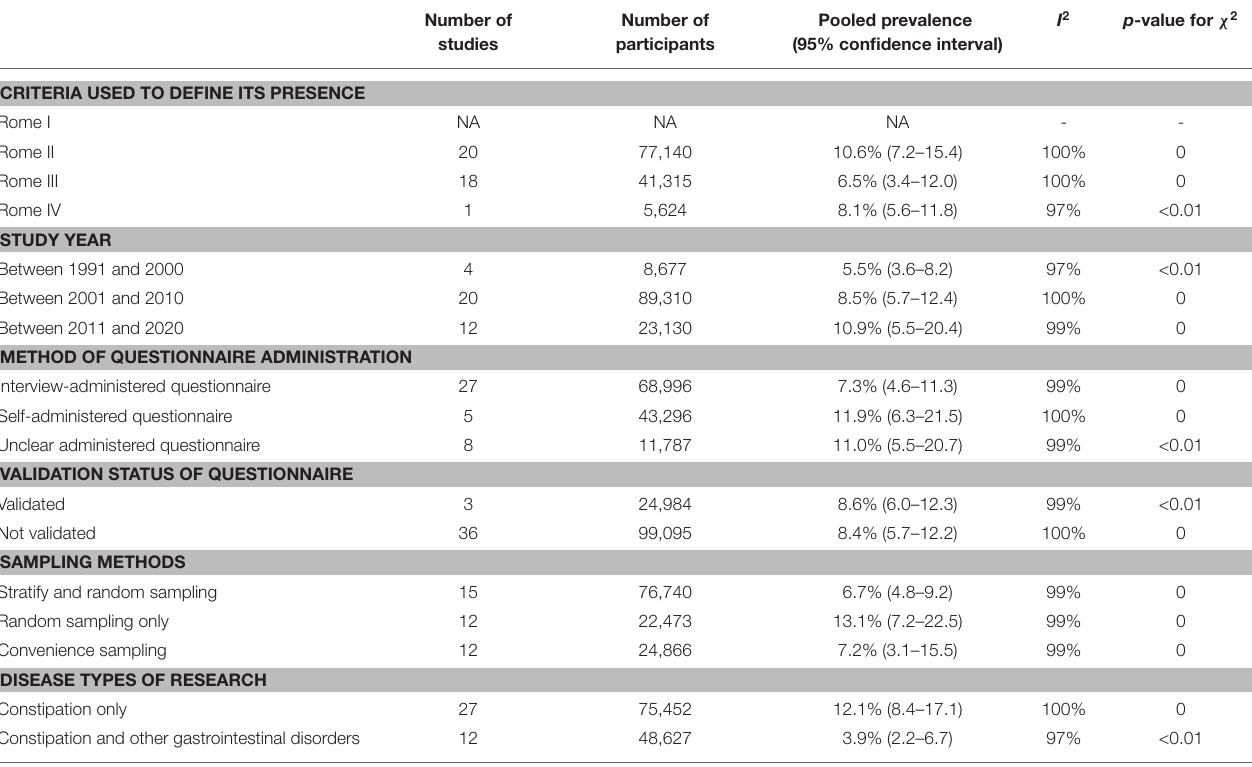
TABLE 1 | Pooled prevalence of functional constipation according to the criteria used to define its occurrence, year of study, method of questionnaire administration, validation status of questionnaire, methods of sampling, and research based on disease types.